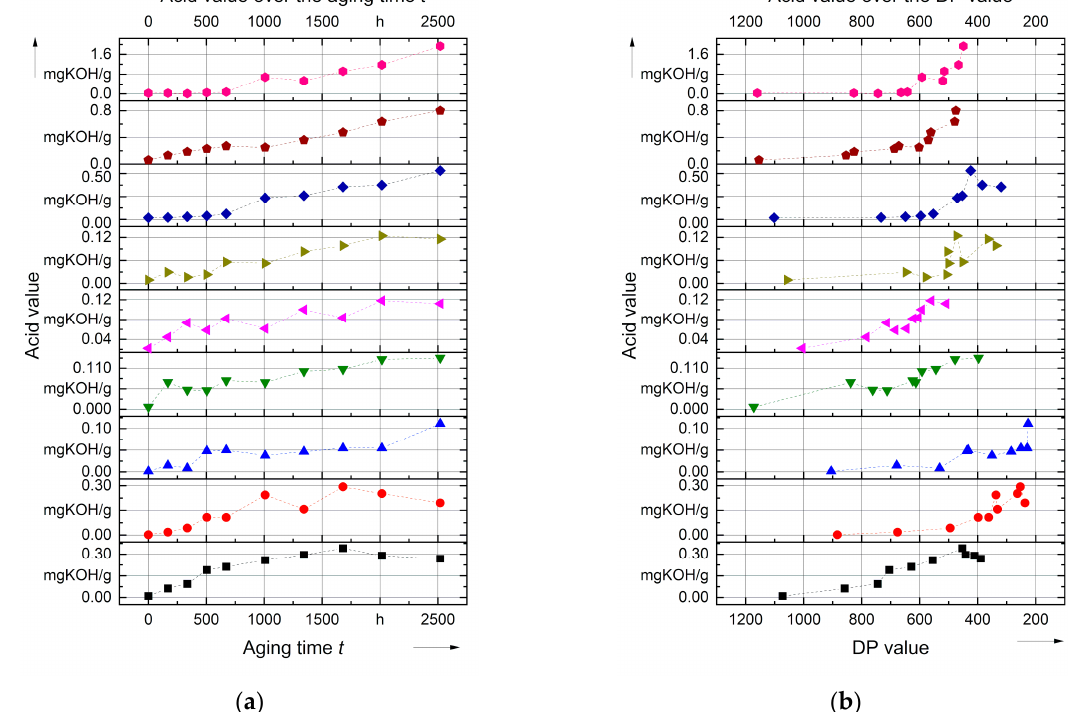
Figure 14. Change of acid value for different sealing systems and fluids: ( a ) Change over the aging time; ( b ) Change over the DP value; the legends refer to Figure 6a.